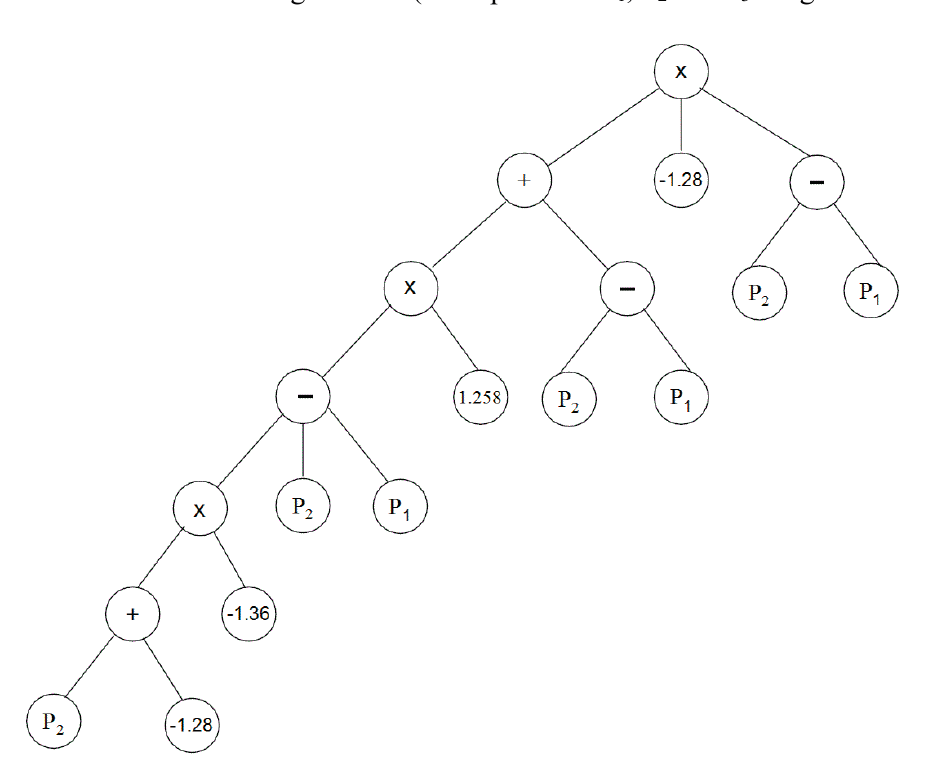
Figure 4. The tree structure representations of symbolic expressions produced by GP for